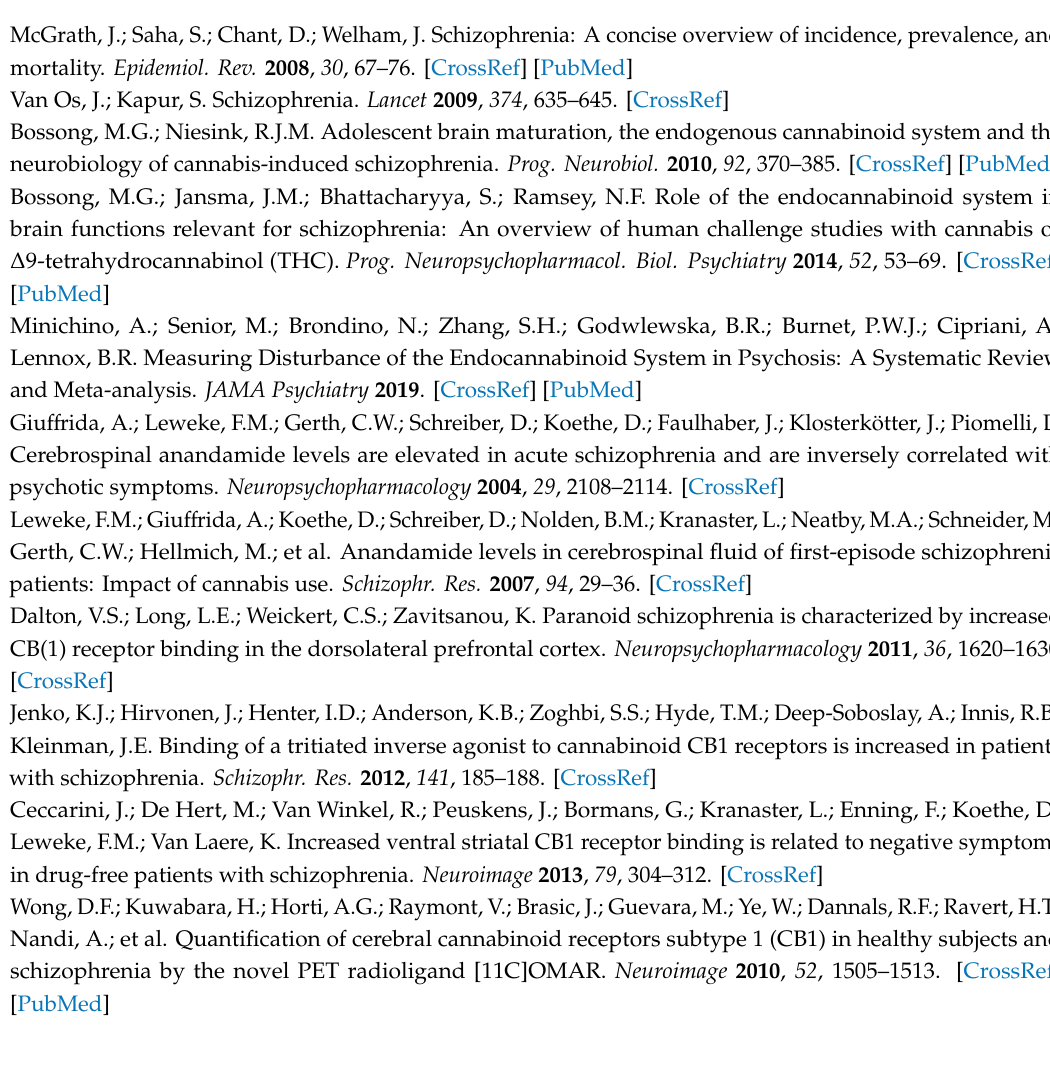
Table S1: Overview of studies included in the present systematic